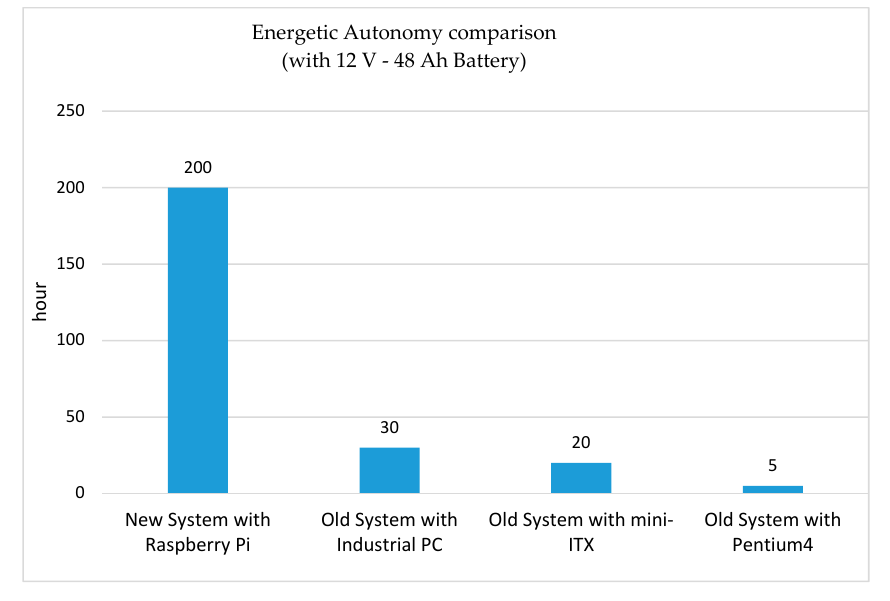
Figure 10. Energetic autonomy comparison between older probes and the new one.